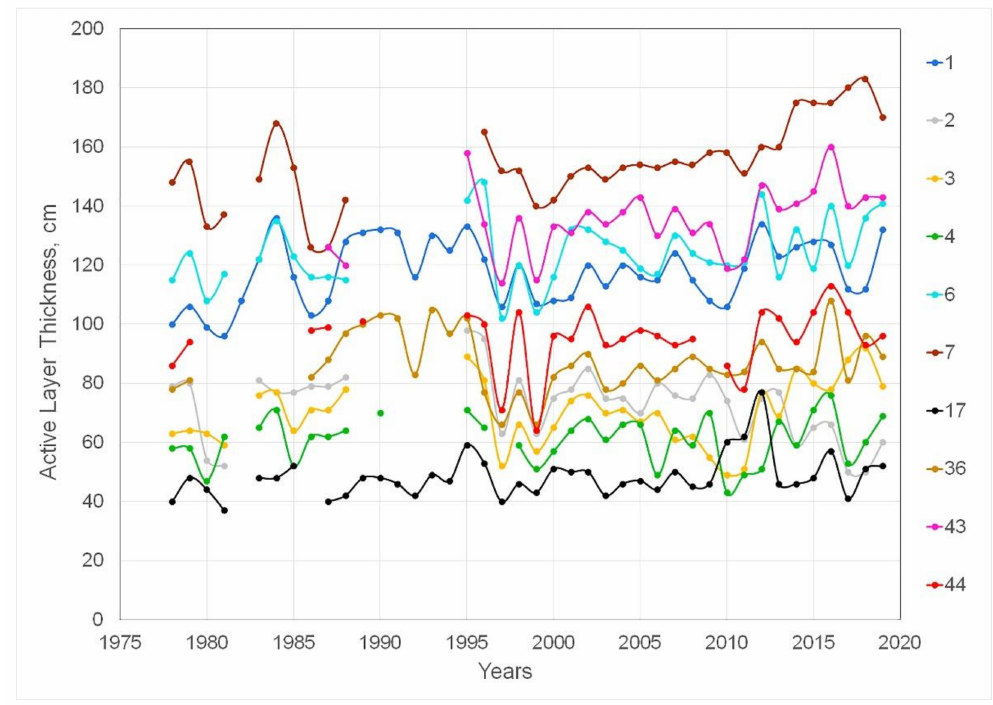
Figure 6. Depth of seasonal thawing in 1978–2019 in the Marre-Sale study area. Numbers of boreholes adjacent to observation sites are shown in the legend (for locations, see Figure